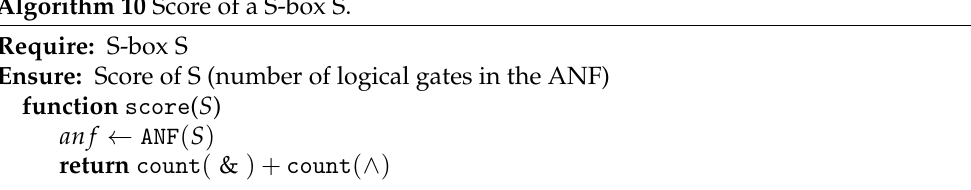
Algorithm 10 Score of a S-box